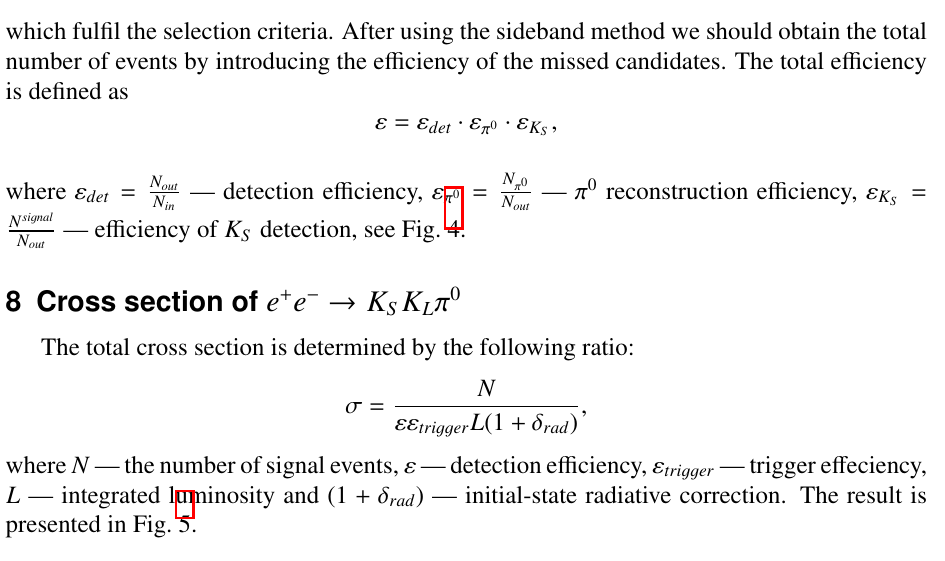
Figure 3. Dependence of π 0 mass on K S mass.